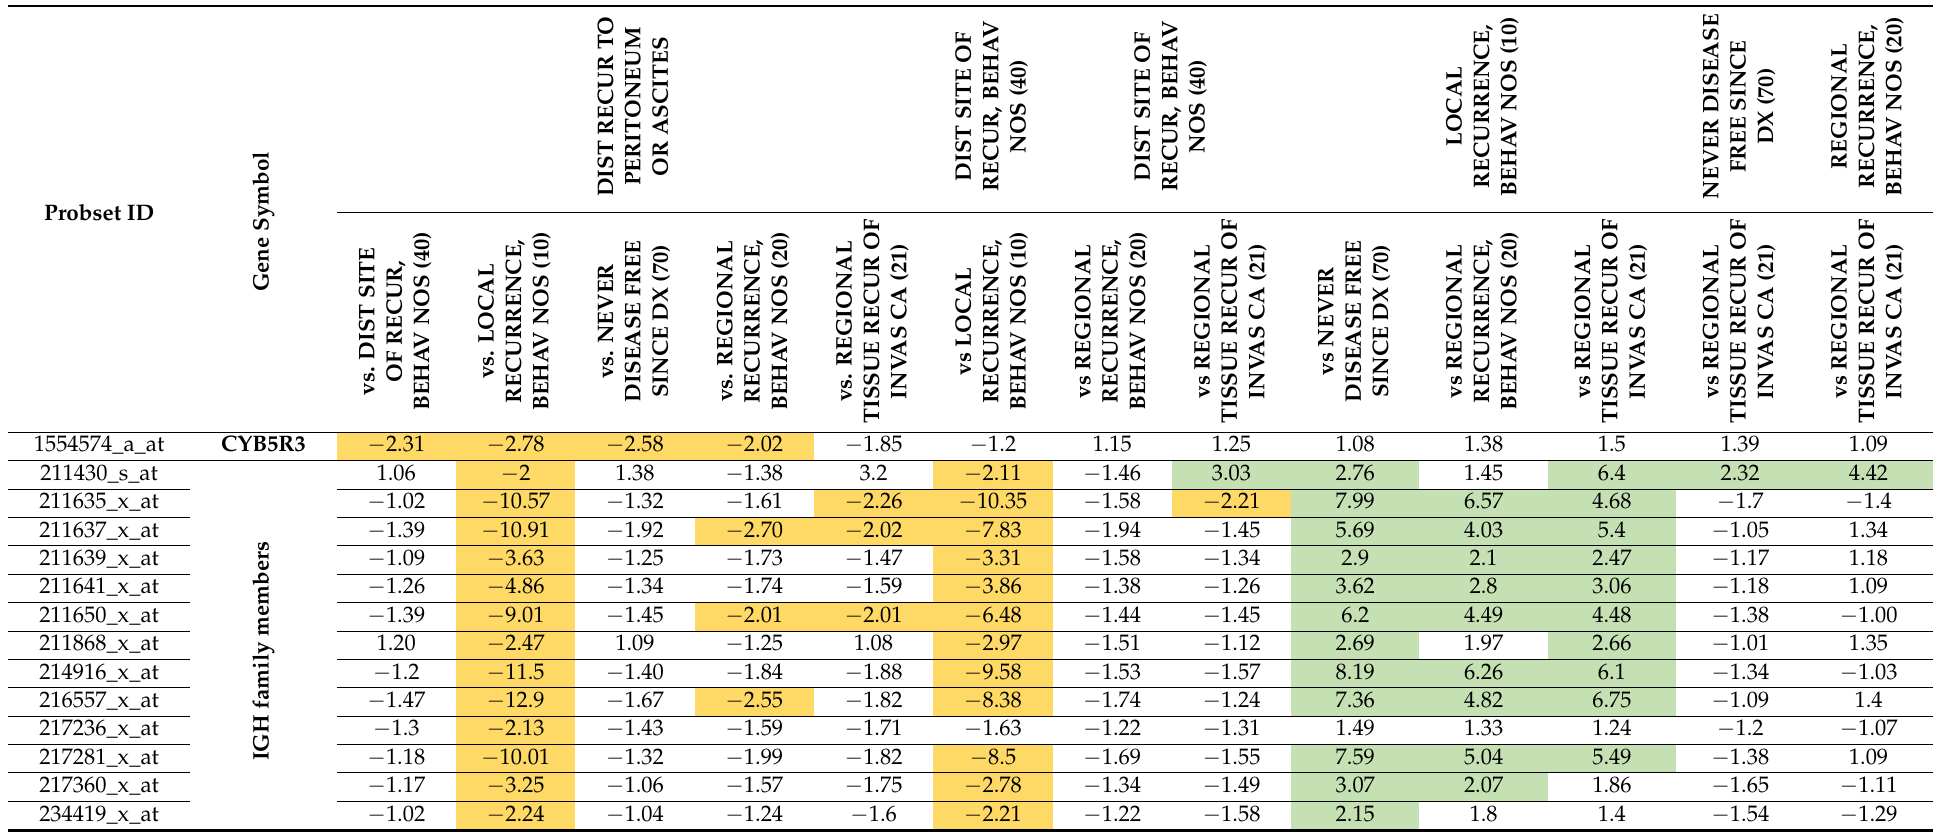
Table 9. Fold change in antigen transcript levels that achieved significance, when comparing recurrence type. Light green cells indicate values that are increased by greater than 2-fold, yellow cells indicate values that are decreased by greater than